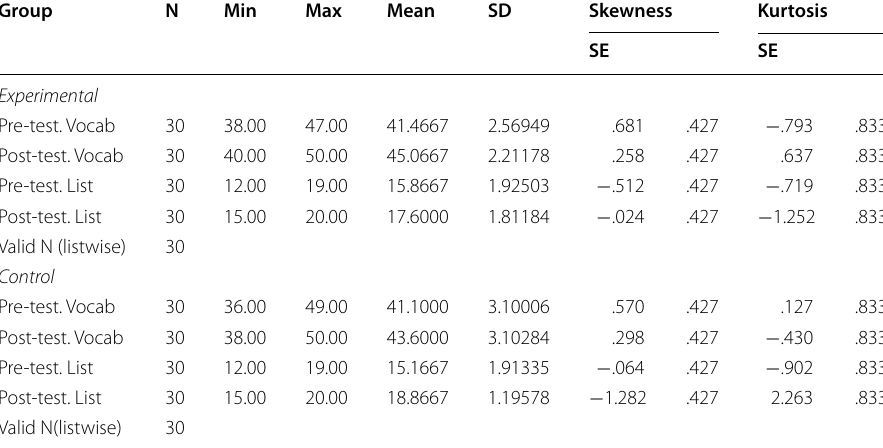
Table 4 Descriptive Statistics Group